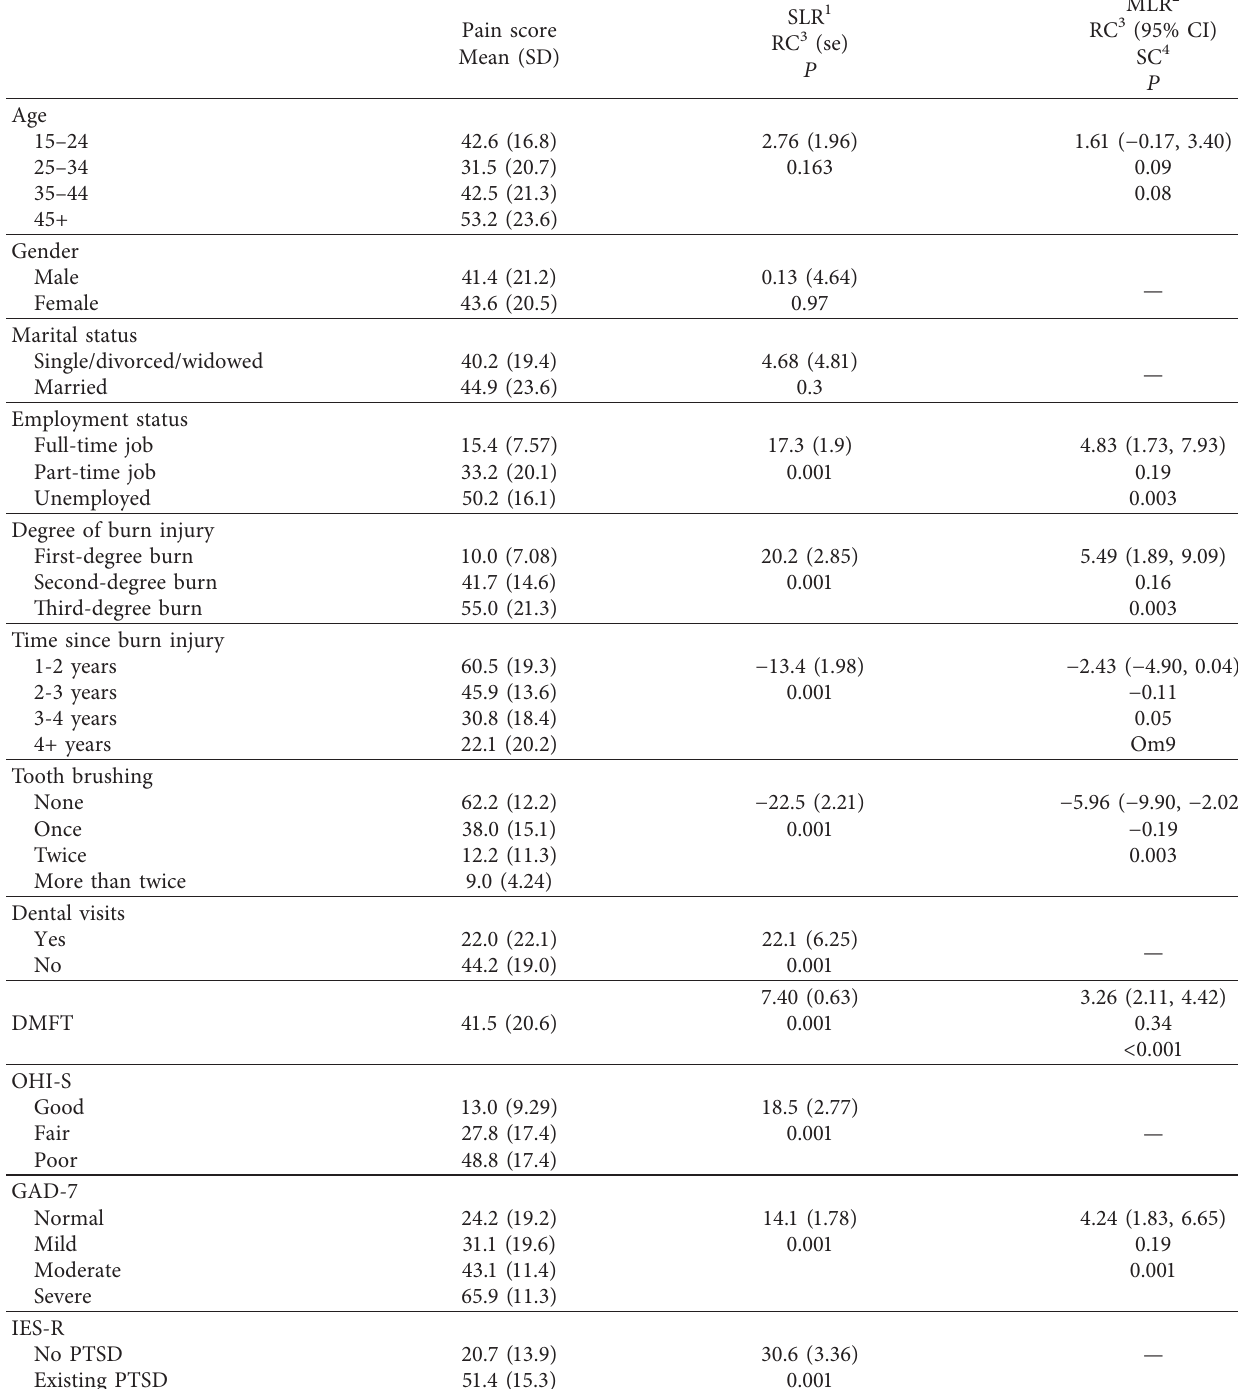
Table 2: Association of pain with sociodemographic, burn characteristic, and psychological